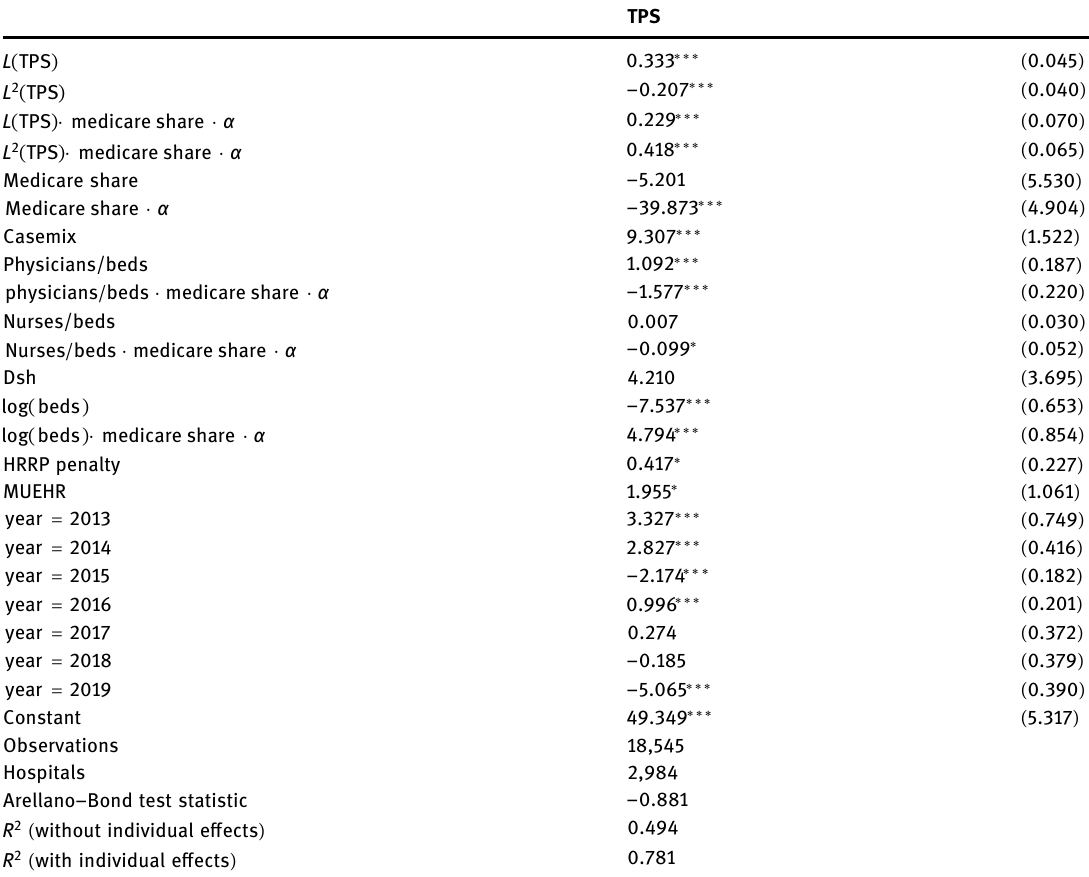
Table A1: Explaining the TPS in Medicare ’ s acute care